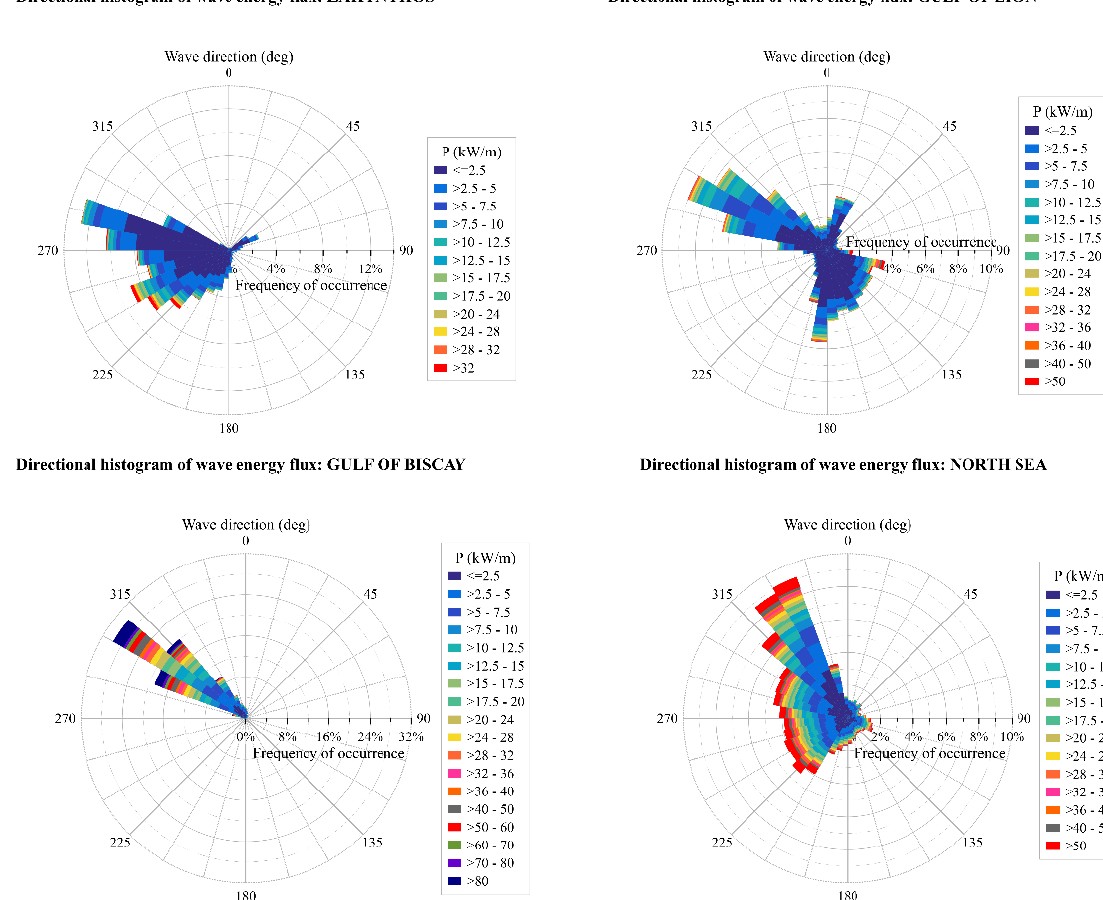
Figure 2. Directional histograms of wave power flux (kW/m) for the examined locations.